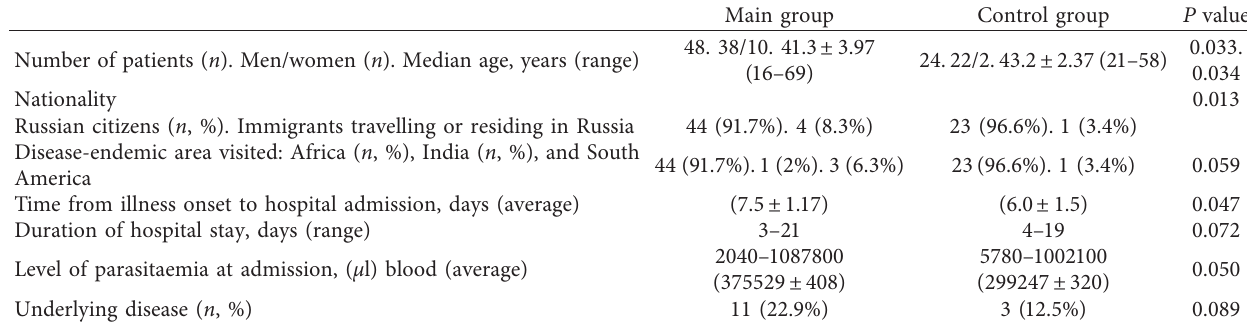
Table 1: General characteristics of patients with imported severe and complicated P. falciparum